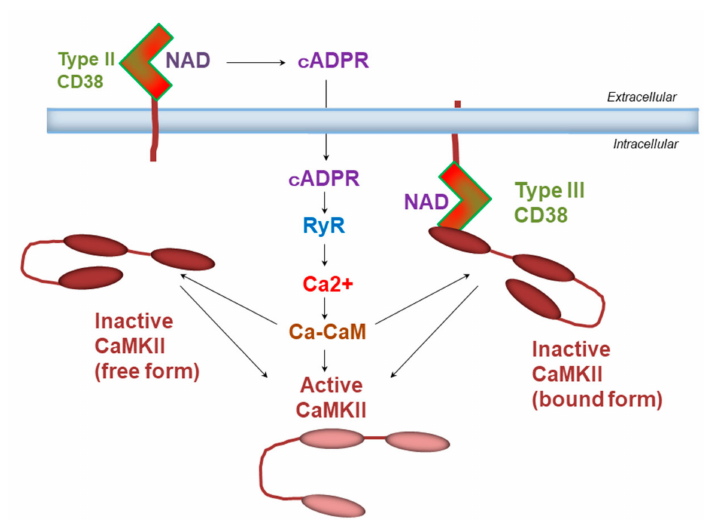
Figure 4. Hypotheses of CD38 and CaMKII interaction. Two models represent the possible means of activation of CaMKII by binding of calmodulin (CaM) and Ca 2 + to the regulatory domain of CaMKII. Ca 2 + is increased from ryanodine receptors bound by cyclic ADP-ribose (cADPR). cADPR is produced by either type II or type III